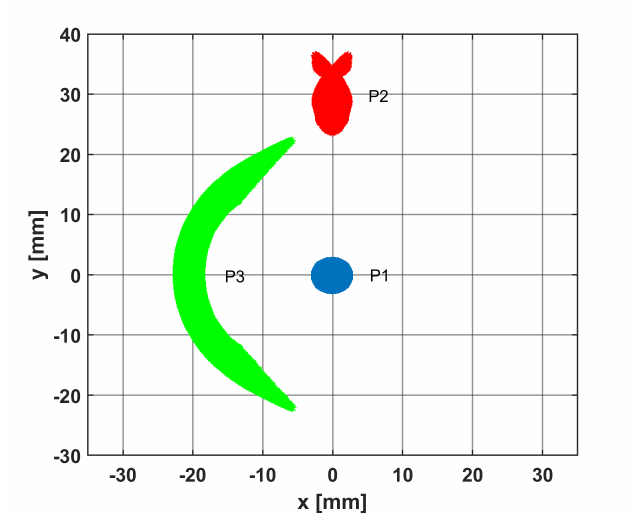
Figure 5. Designed cluster of three sensors: a reference circular sensor P1 and two reshaped sensors, P2 and